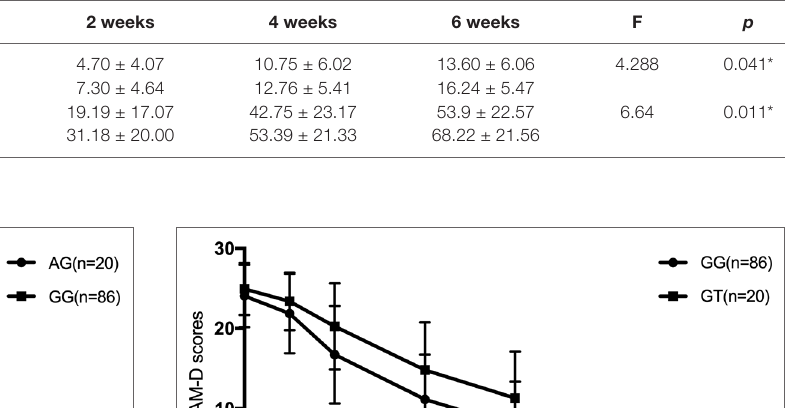
TABLE 8 | Rs2235040 and response to antidepressants.